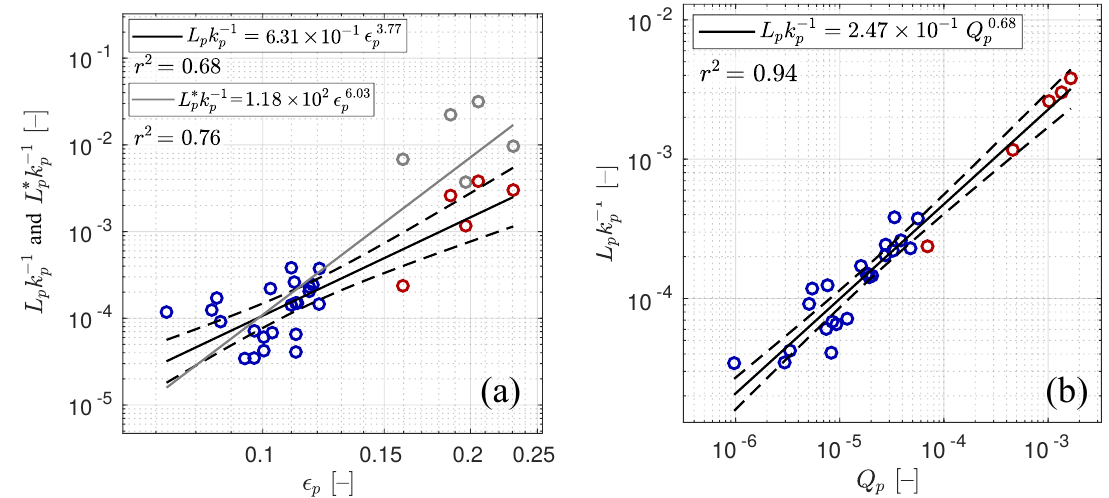
Figure 9. ( a ). The total length of whitecaps of dominant waves per unit surface area, L p , normalised by the peak wavenumber, k p , as a function of the dominant wave steepness, (cid:101) p . ( b ) The same quantity, but as a function of the active whitecap coverage of dominant waves, Q p . Notation and colour-coding are the same as in Figure 8. Gray markers are for the recovered L ∗ p at the offshore winds, which represents the total length of the breaking fronts of dominant waves. The gray line corresponds to the power fit to the total cloud of points when red markers are replaced with gray